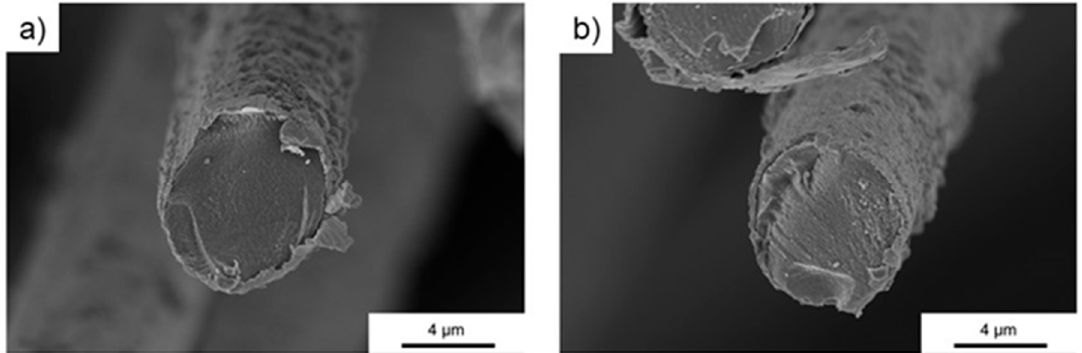
Figure 2. SEM cross-section images of the nickel-coated fiber ( a ) overview picture, ( b ) marked section magnified.